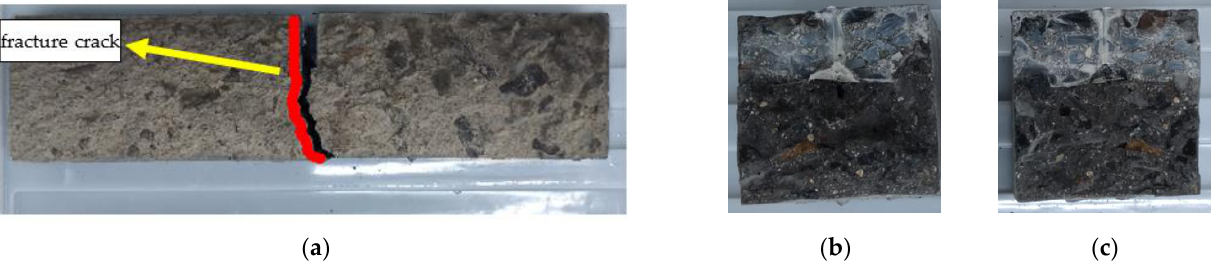
Figure 23. Failure mode of URFSF-100: ( a ) side surface; ( b ) fracture surface 1; and ( c ) fracture surface 2.